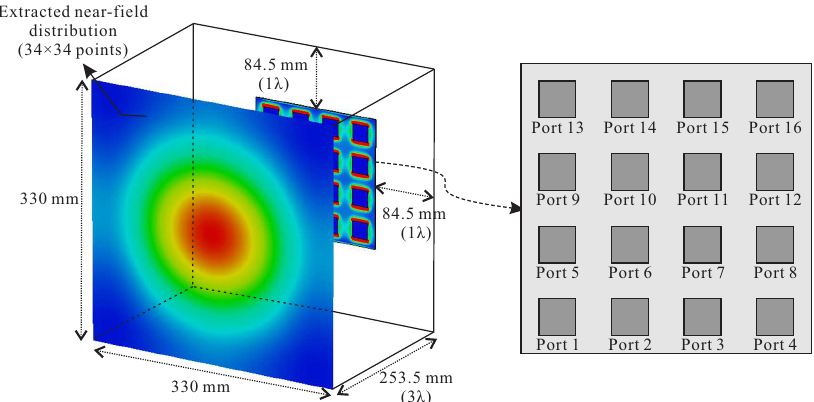
Figure 2. Near-field data extraction simulation environment in CST MWS.